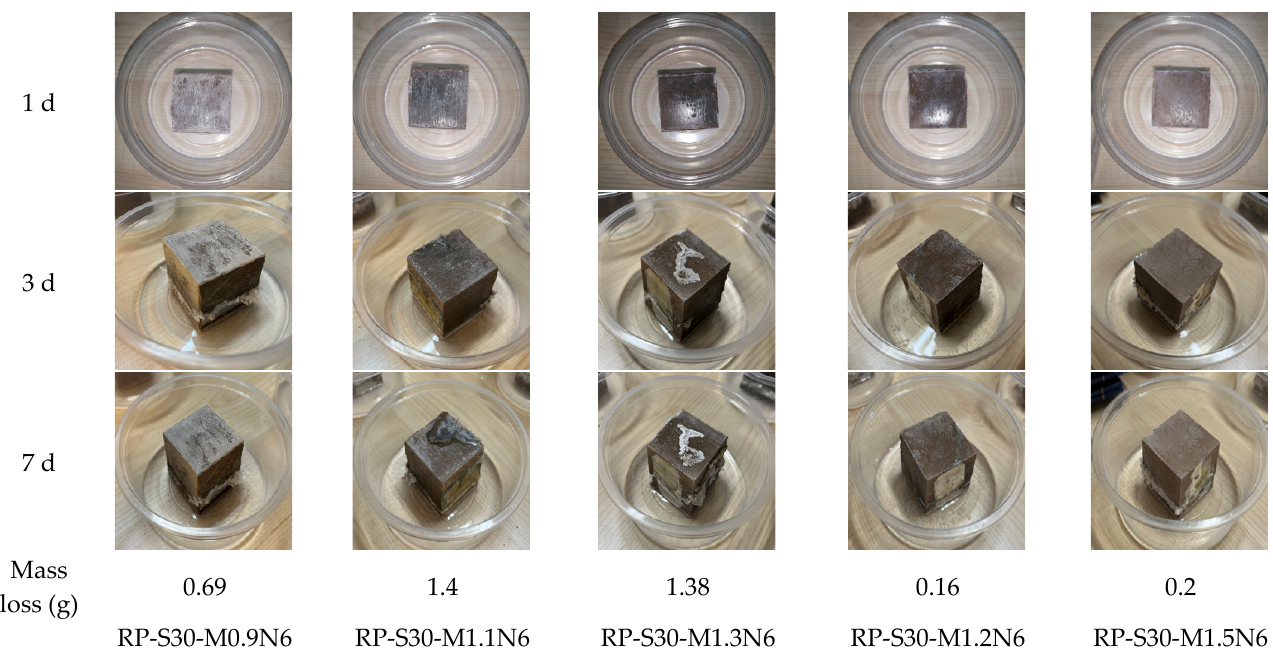
Figure 13. Visual efflorescence of RPSG with different moduli.